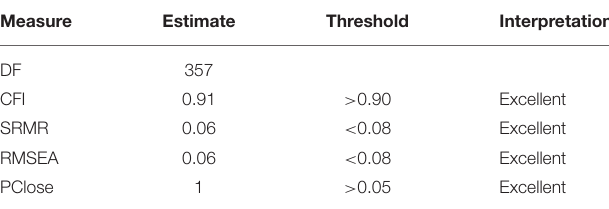
TABLE 5 | SEM model goodness-of-fit.